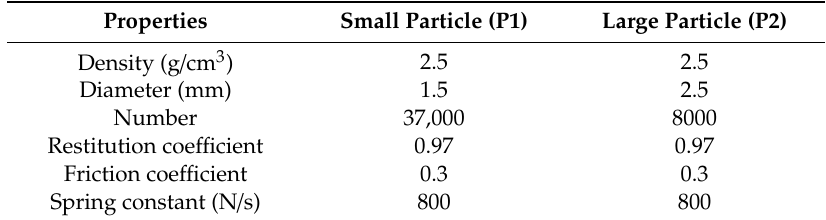
Table 1. Physical parameters of small and large particles used in simulations.